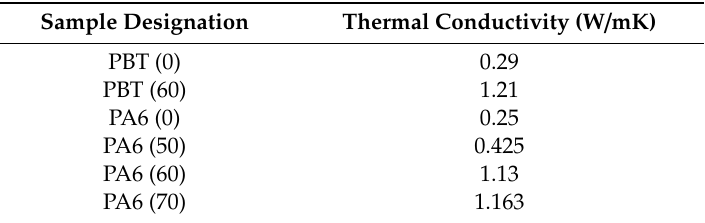
Table 3. Thermal conductivity of PBT, PA6, and Al 2 O 3 composites.